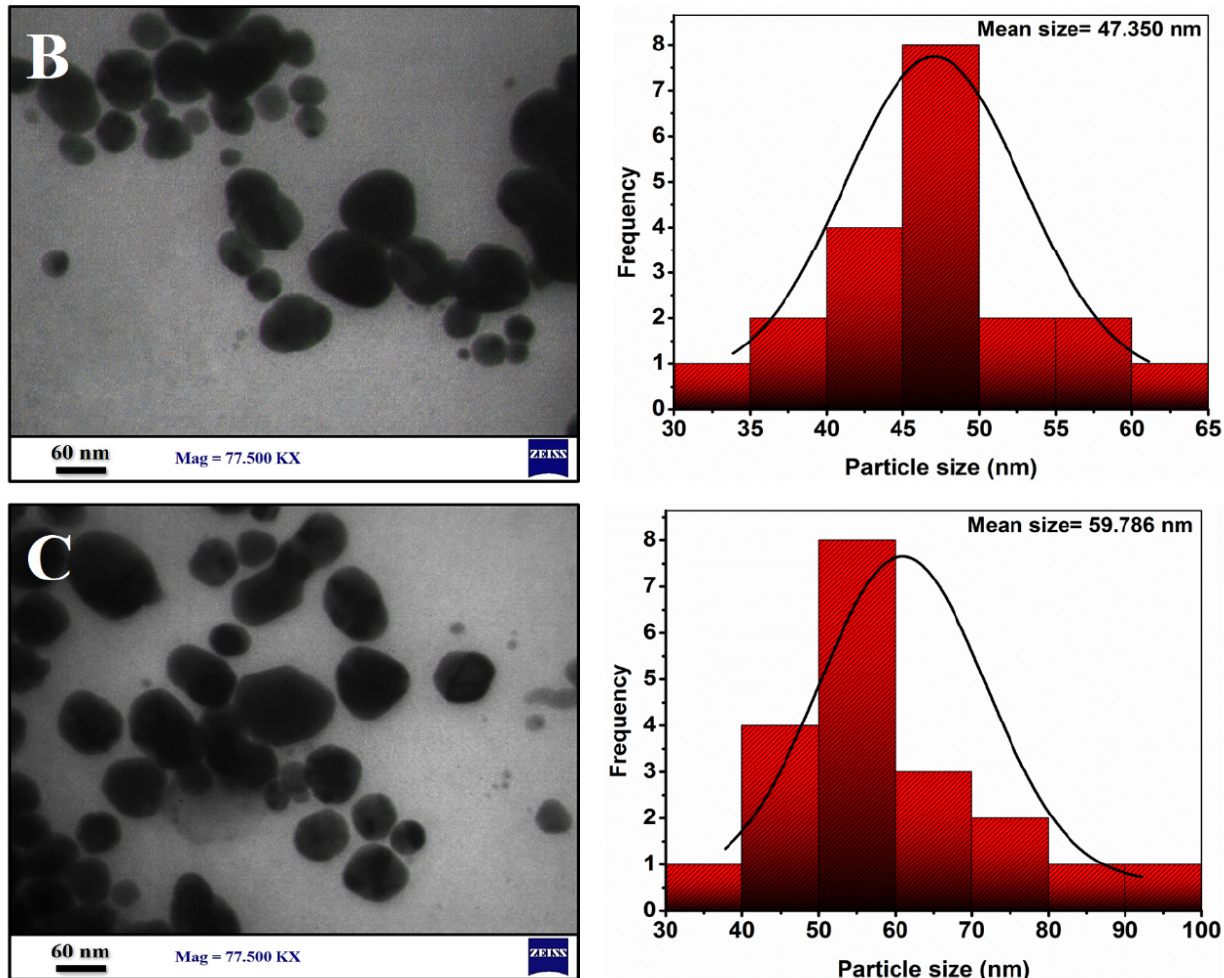
Figure 11. TEM images of AgNPs and their conjugates: ( A ) AgNPs, ( B ) AgNPs-PEG, and ( C ) AgNPs-PEG-CIP.